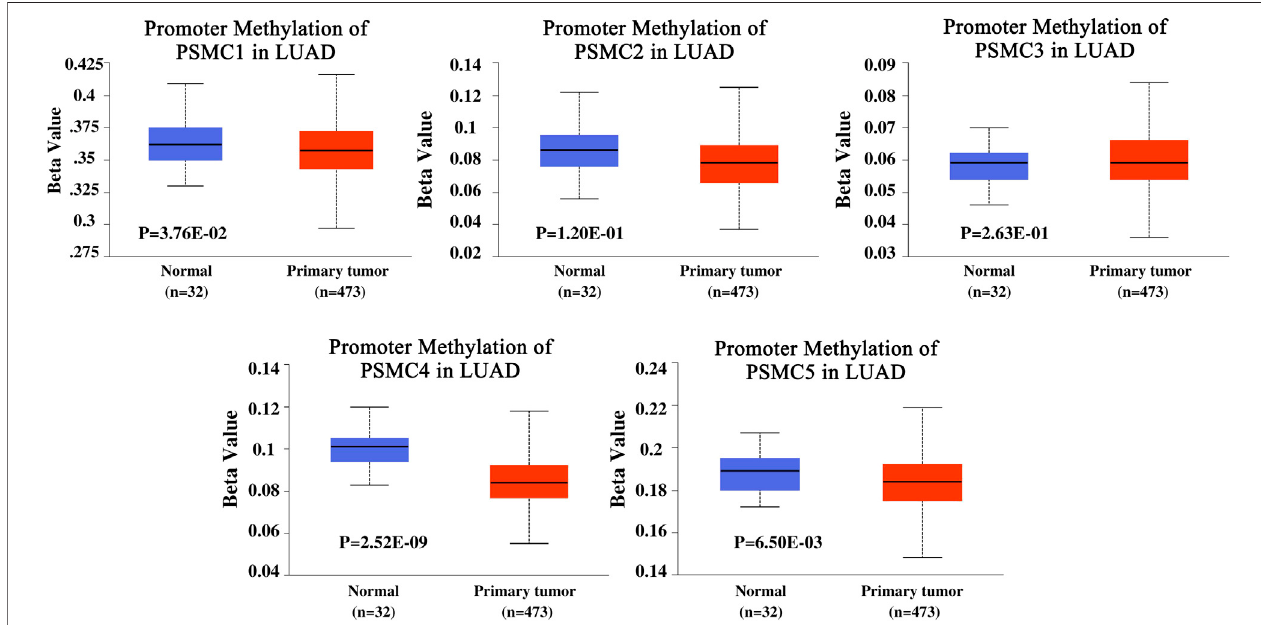
FIGURE 4 | Promoter methylation pattern of PSMC genes in LUAD and normal lung tissues. Signi fi cant and distinct differential methylation patterns of different PSMC s in LUAD tissues was observed compared to the normal lung tissues. Normal: samples were collected from normal tissues adjacent to the cancerous tissues of LUAD patients within TCGA cohorts without any demographic and clinical strati fi cation (Source: The Cancer Genome Atlas). Beta value cut-offs in the range of 0.7 to 0.5 indicate hypermethylation; 0.3 – 0.25 indicates hypomethylation.